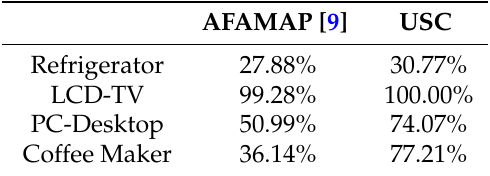
Table 6. Precision results obtained with Kolter and Jaakkola [9]’s Additive Factorial Approximate MAP (AFAMAP) algorithm in basic and with Usage Statistics Conditioning